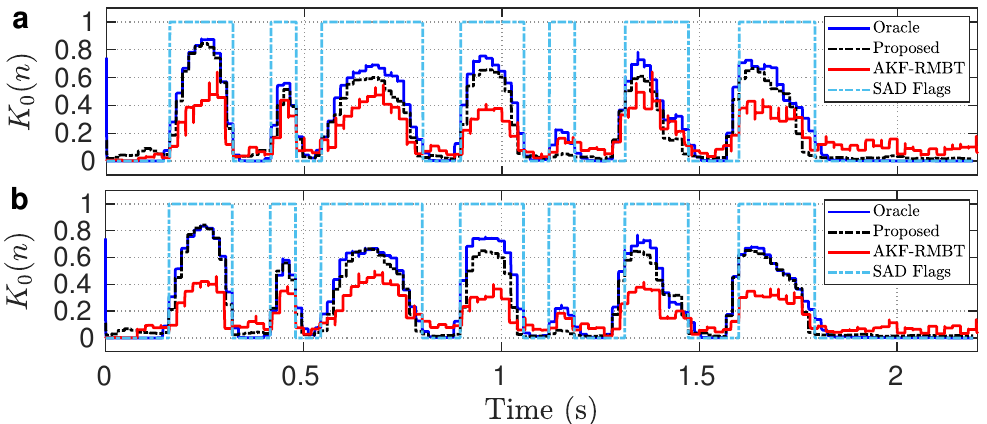
Figure 7. Comparing K 0 ( n ) obtained using KF-pracle, proposed, and AKF-RMBT [22] methods from the utterance sp05 corrupted with 5 dB: ( a ) non-stationary ( babble ) and ( b ) colored ( f16 )